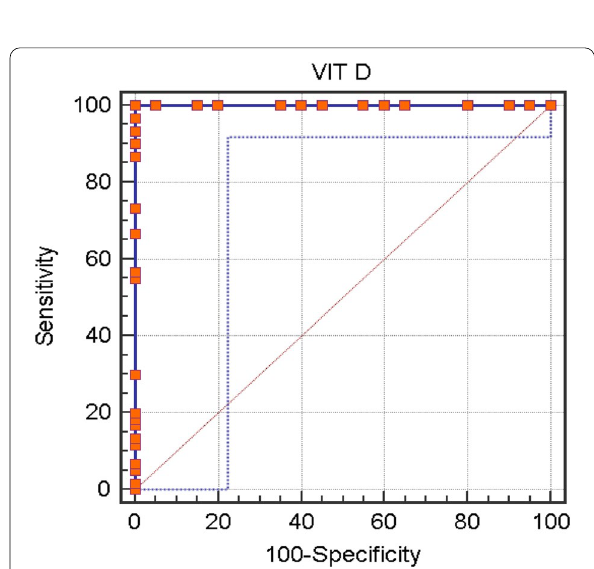
Fig. 1 ROC curve for diagnostic performance of vitamin D in detecting COVID-19